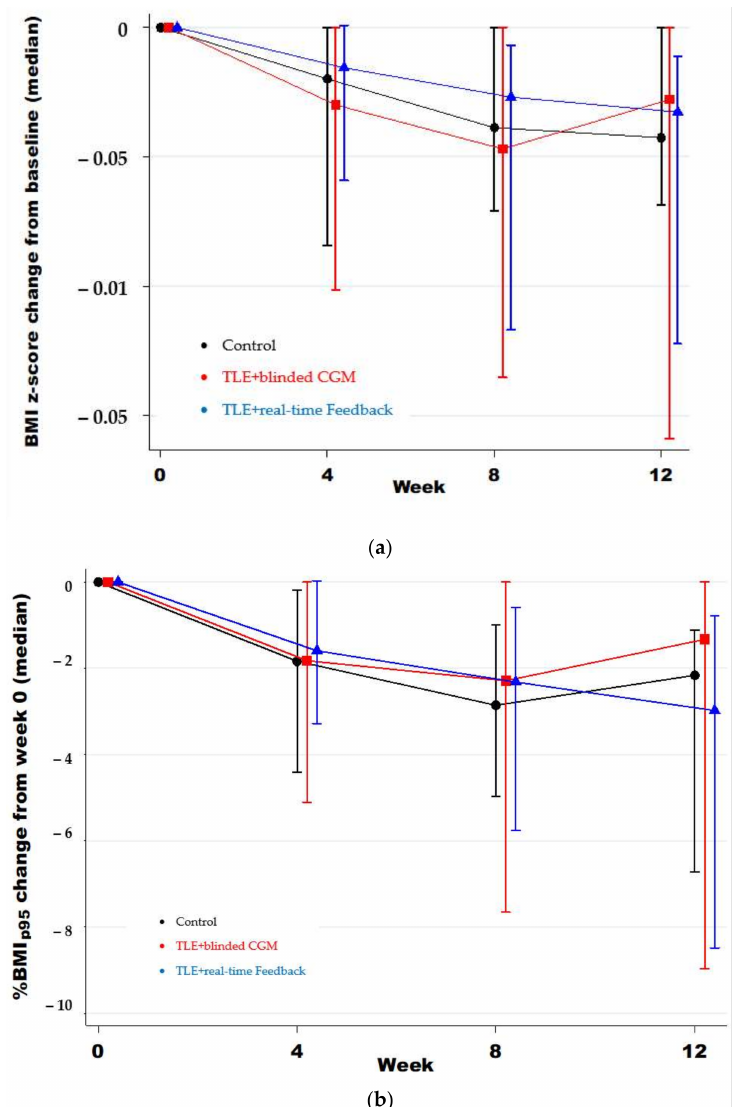
Figure 3. Weight change across the study period by intervention group for ( a ) change in excess percent of the 95th percentile (%BMI p95 ) and ( b ) change in BMI